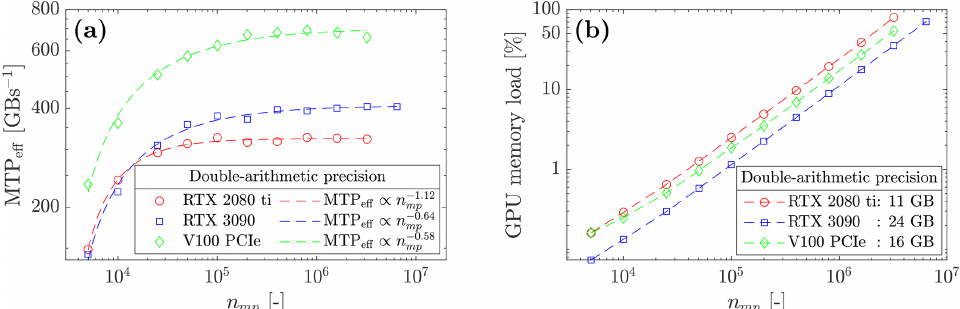
Figure 12. (a) Effective memory throughput MTP eff of the solver ep2-3De v1.0 for double-arithmetic precision. One can see the on-chip memory limit, as neither the RTX 2080 Ti nor V100 can resolve the same number of material points as the RTX 3090. (b) GPU on-chip memory load increases with the number of material points n mp , which demonstrates, as expected, one of the GPU’s hardware limits.